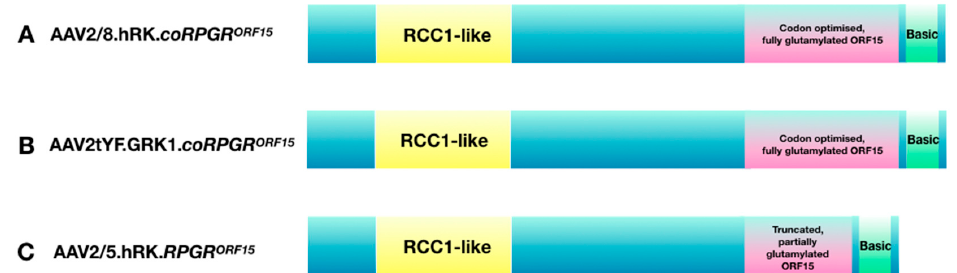
Figure 4. AAV vector constructs used in current gene therapy trials: ( A ) the Nightstar Therapeutics (now Biogen Inc) trial, NCT03116113; ( B ) the Applied Genetic Technologies Corporation trial, NCT03316560; ( C ) the MeiraGTx trial, NCT03252847.